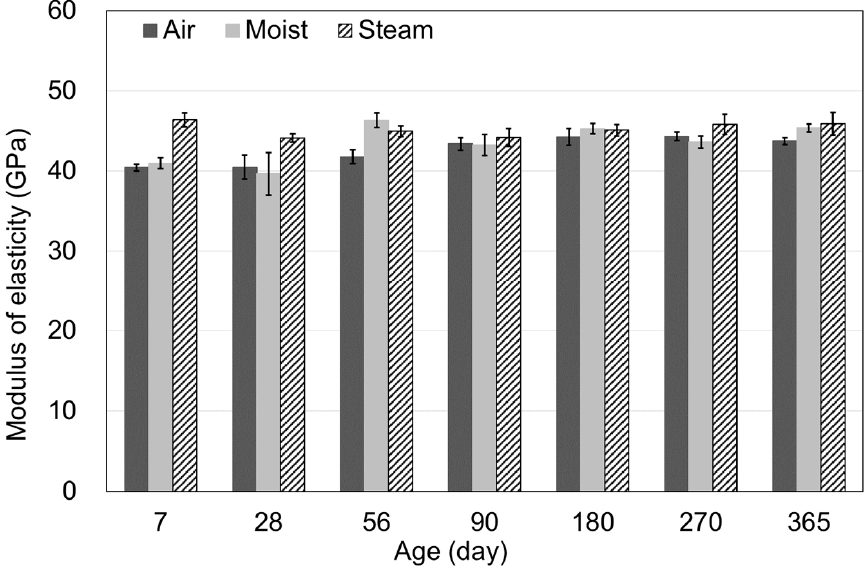
Figure 10. Elastic modulus according to the curing